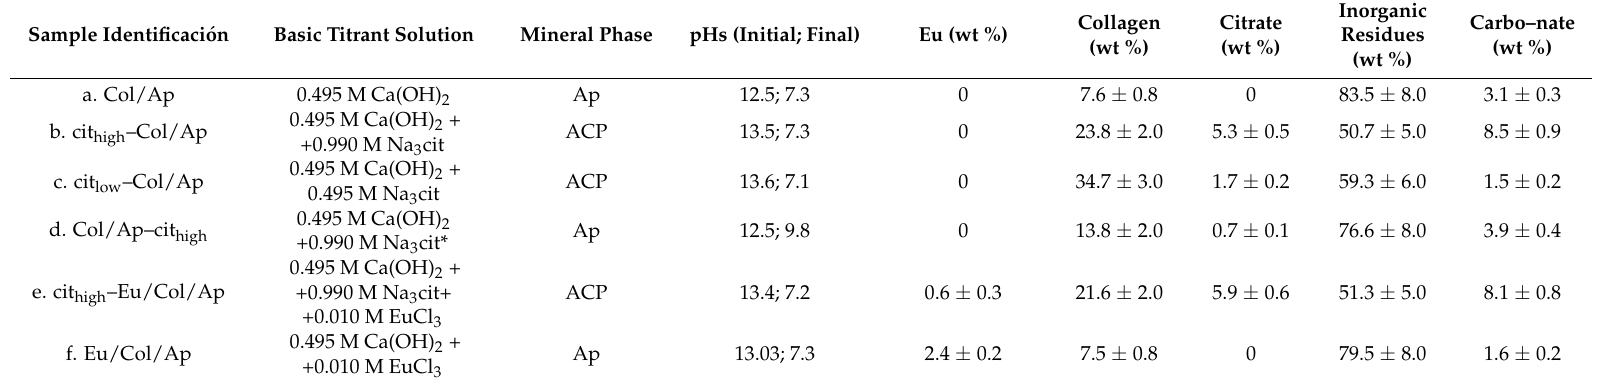
Table 1. Codes, details of the basic titrant solutions and composition of mineralized